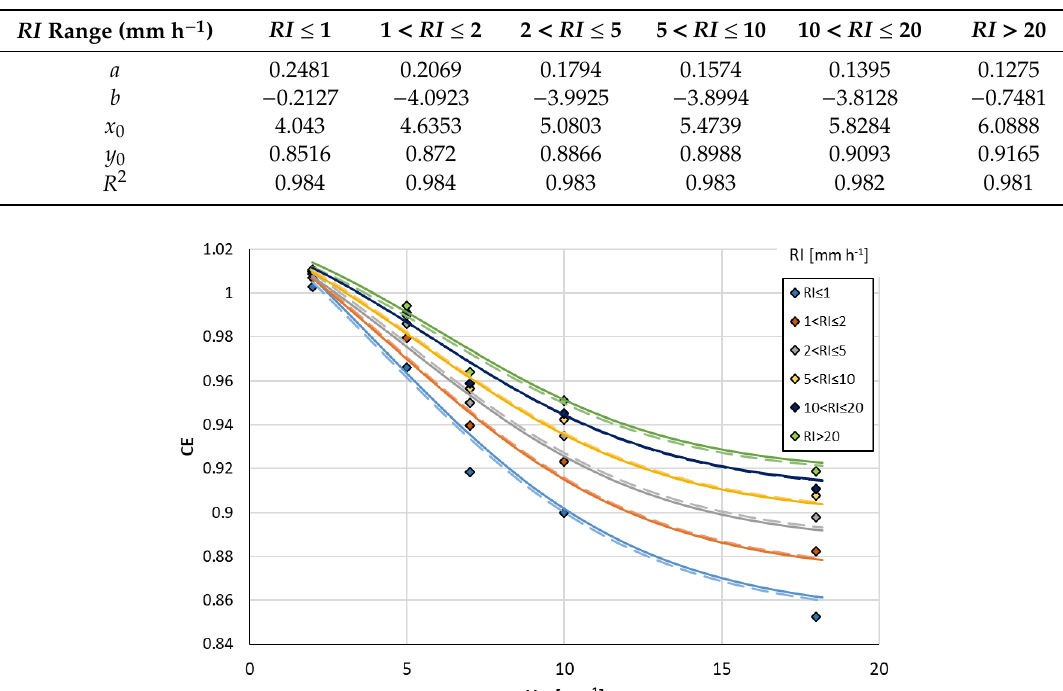
Figure 7. Raw CE values (diamonds) obtained by using the MP parameters derived from the exponential interpolation in step ( a ), for each RI class, and CE curves obtained by expressing 𝑁 0 and Λ as a function of RI (dashed lines) in step ( b ) and by expressing the sigmoidal parameters as a function of RI (continuous lines) in step ( c ).